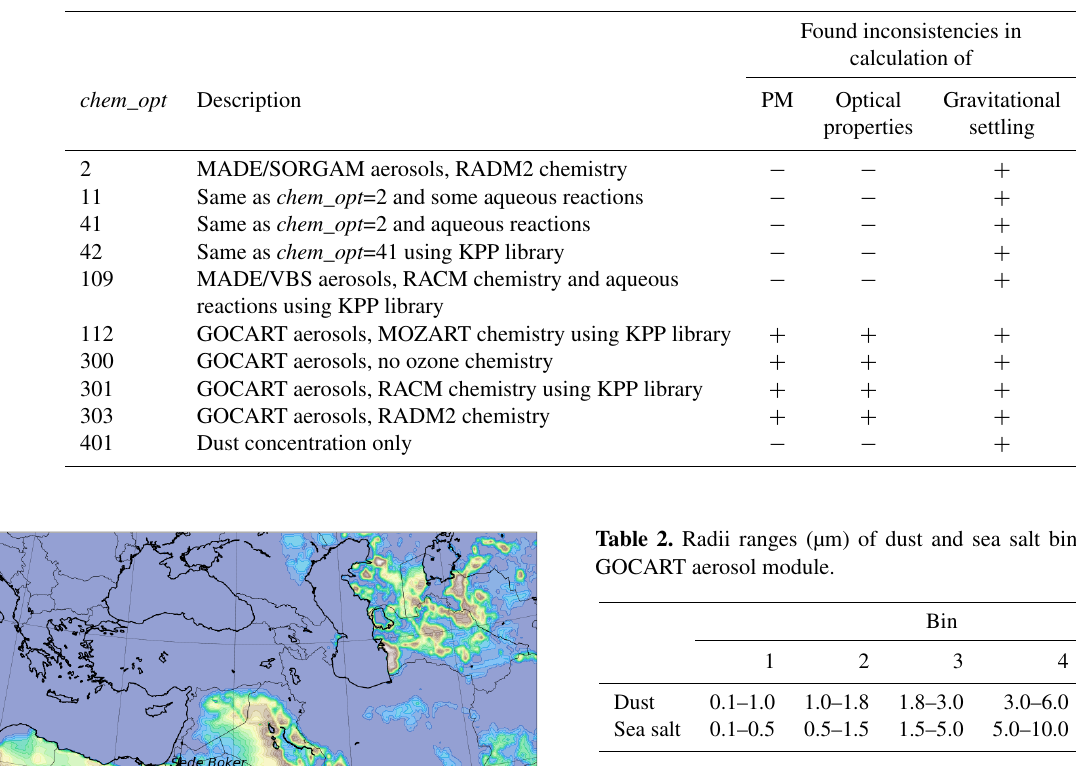
Table 1. WRF-Chem chem_opt namelist options affected by the found inconsistencies.